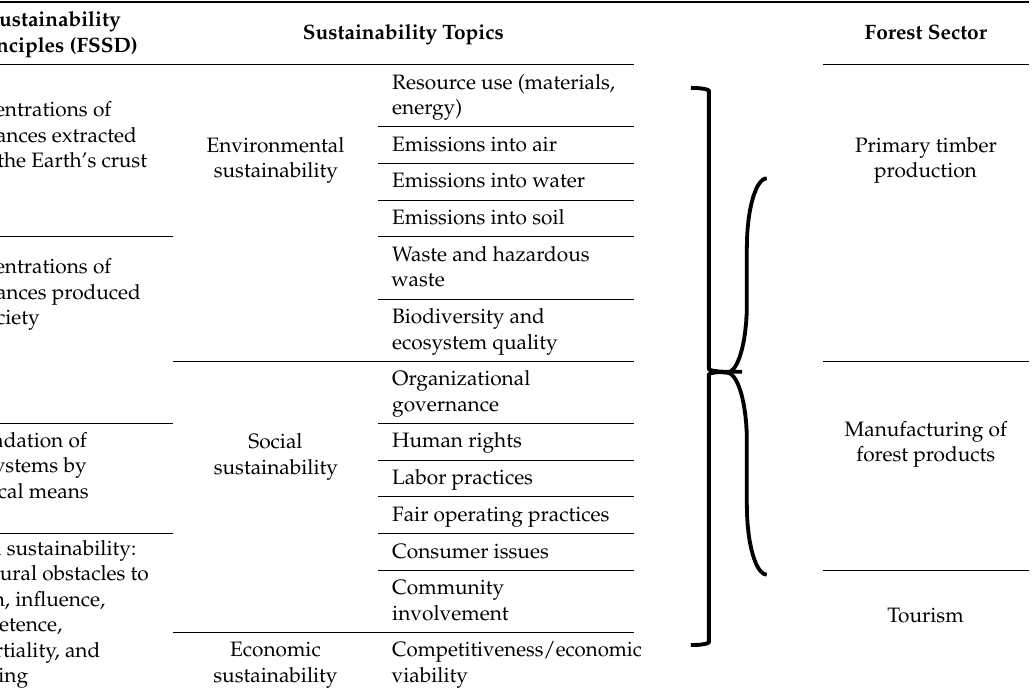
Table 1. Sustainability principles and sustainability topics related to the forest sector (see [19,20] for the Framework for Strategic Sustainable Development (FSSD) and [26,27] for sustainability topics).